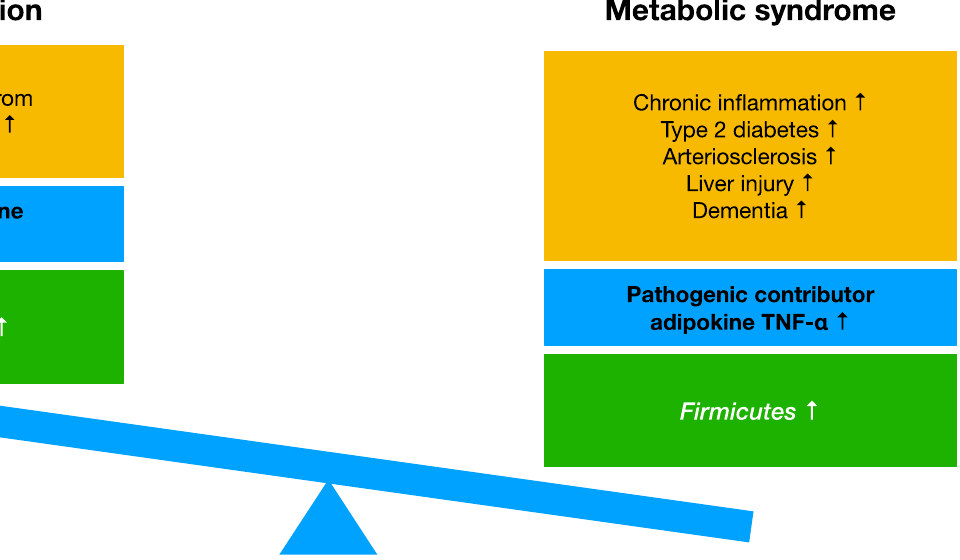
Figure 1. The mechanism of onset and suppression of metabolic syndrome . High-fat, high-glucose and typical Western diet causes accumulation of excess energy in the body, reduction of protective adipokine adiponectin, and increase of pathogenic contributor adipokine TNF- α induces chronic inflammation and metabolic syndrome. Metabolic syndrome induces type 2 diabetes, arteriosclerosis, and dementia. In metabolic syndrome, gut microbiota induces dysbiosis. Increased Firmicutes and decreased Bacteroidetes in the gut microbiota induce chronic inflammation and metabolic-syndrome-related disorders. Healthy diet and exercise prevent obesity, maintain good gut microbiota, and suppress metabolic syndrome.